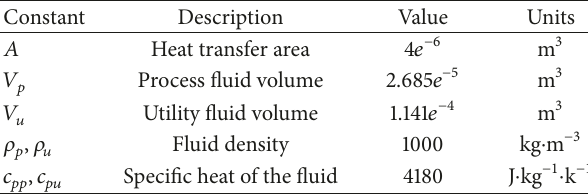
Table 1: Physical data used in the pilot.